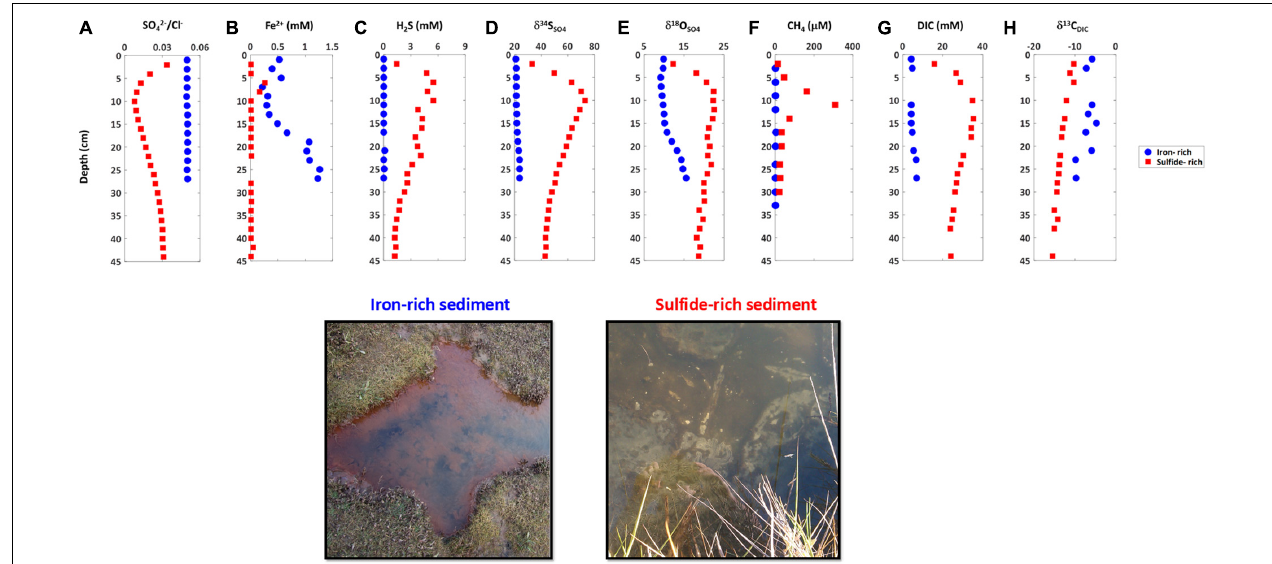
FIGURE 2 | Pore water chemical profiles and picture of the surface sediment of iron-rich (blue circles) and sulfide-rich sediment cores (red squares) taken from Norfolk in October 2014. (A) Sulfate to chloride ratio, (B) ferrous iron, (C) sulfide, (D) sulfur isotope ratio in sulfate, (E) oxygen isotope ratio in sulfate, (F) methane, (G) dissolved inorganic carbon, (H) carbon isotope ratio in dissolved inorganic carbon.